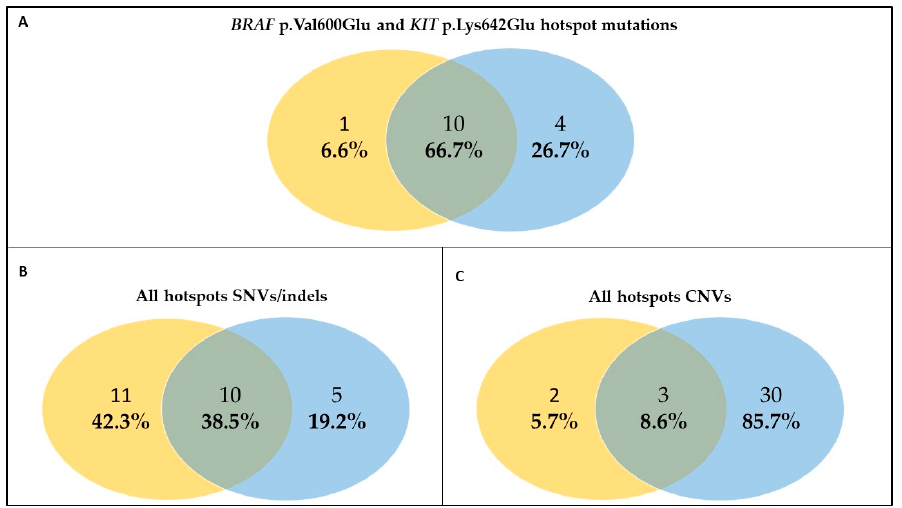
the concordance between cfDNA (yellow circle) and tumor tissue (blue circle) when considering only BRAF p.Val600Glu and KIT p.Lys642Glu hotspot mutations ( A ), all hotspot SNVs/indels ( B ), all hotspot CNVs ( C ). Abbreviations: SNVs: Single Nucleotide Variants; indels: insertions/deletions; CNVs: Copy Number Variations. (WES)